Question: Author a descriptive caption for the visualization shown.
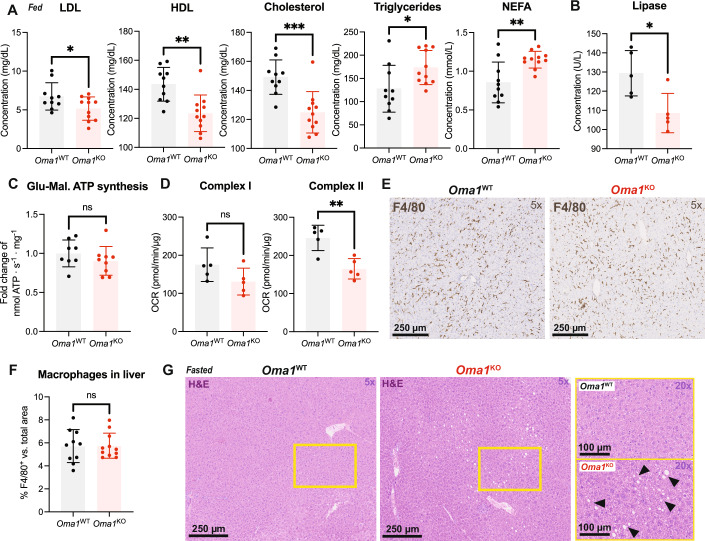
Answer: Early liver dysfunction in young Oma1 KO mice. ( A ) Fed-state values of plasma LDL ( P = 0.0410), HDL ( P = 0.0014), total cholesterol ( P = 0005), NEFAs ( P = 0.0029), and TAGs ( P = 0.0272) in 10-week-old male Oma1 WT ( n = 10) and Oma1 KO ( n = 11) mice (mean ± SD). ( B ) Plasma lipase ( P = 0.0180) in 10-week-old male Oma1 WT ( n = 5) and Oma1 KO ( n = 5) mice. ( C ) ATP synthesis production using glutamate-malate in liver isolated mitochondria from 10-week-old male mice fed Oma1 WT ( n = 8) and Oma1 KO ( n = 9) mice (mean ± SD). ( D ) Basal oxygen consumption rate from complex I and complex II ( P = 0.0028) substrates in frozen isolated mitochondria from male Oma1 WT ( n = 5) and Oma1 KO ( n = 5) livers (left). Complex II-driven OCR seahorse profile (right) (mean ± SD). ( E ) Representative F4/80 staining analysis of 10-week-old male fed Oma1 WT ( n = 10) and Oma1 KO ( n = 11) paraffin liver sections. ( F ) F4/80 staining analysis of 10-week-old male fed Oma1 WT ( n = 10) and Oma1 KO ( n = 11) paraffin liver sections (mean ± SD). ( G ) Representative H&E staining analysis of 6-h fasted 10-week-old male Oma1 WT ( n = 10) and Oma1 KO ( n = 11) paraffin liver sections. Magnifications are depicted to the right to better visualize lipid droplets (black arrows) in fasted livers. P value from unpaired two-tailed Student’s t test (when data passed normality) or Mann–Whitney test (when data did not pass normality) is represented in each graph. ns P > 0.05, ∗ P < 0.05, ∗∗ P < 0.01, ∗∗∗ P < 0.001, and ∗∗∗∗ P < 0.0001.